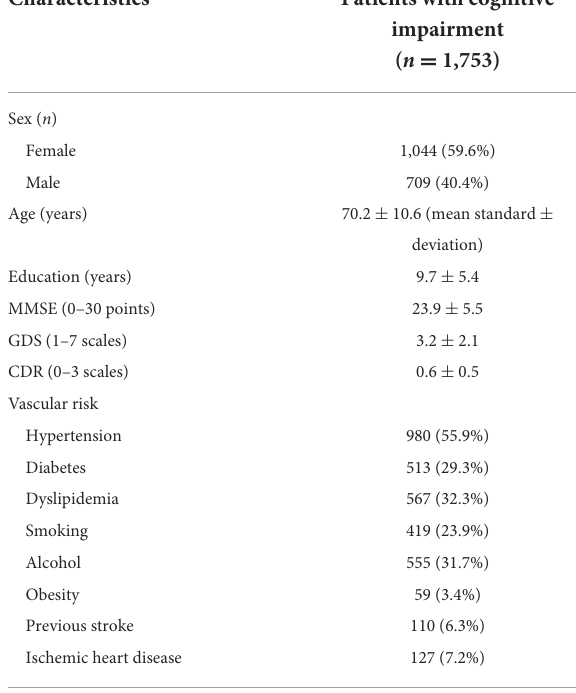
included patients are presented in Table 1. The